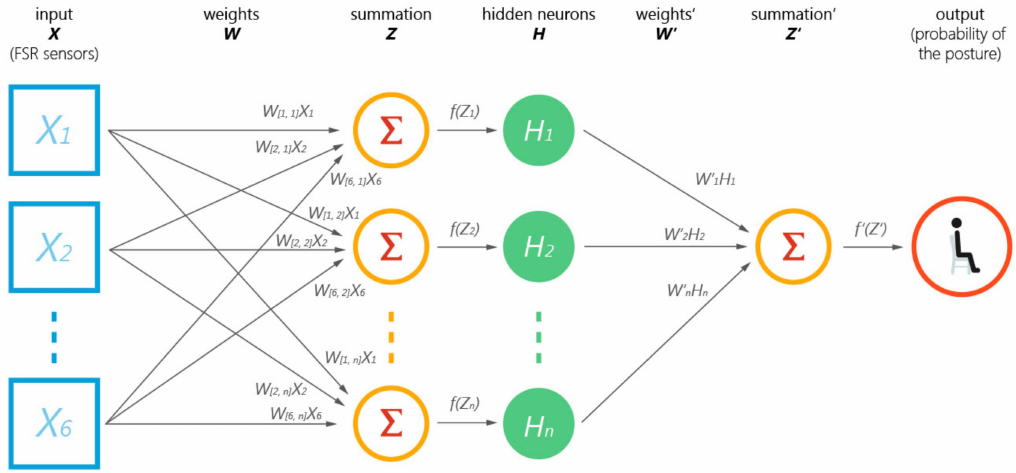
Figure 3. The artificial neural network (ANN) used in LightSit.